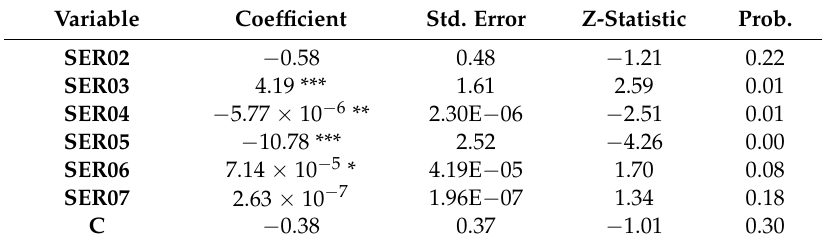
Table 7. Results of Tobit regression analysis on EGE influencing factors